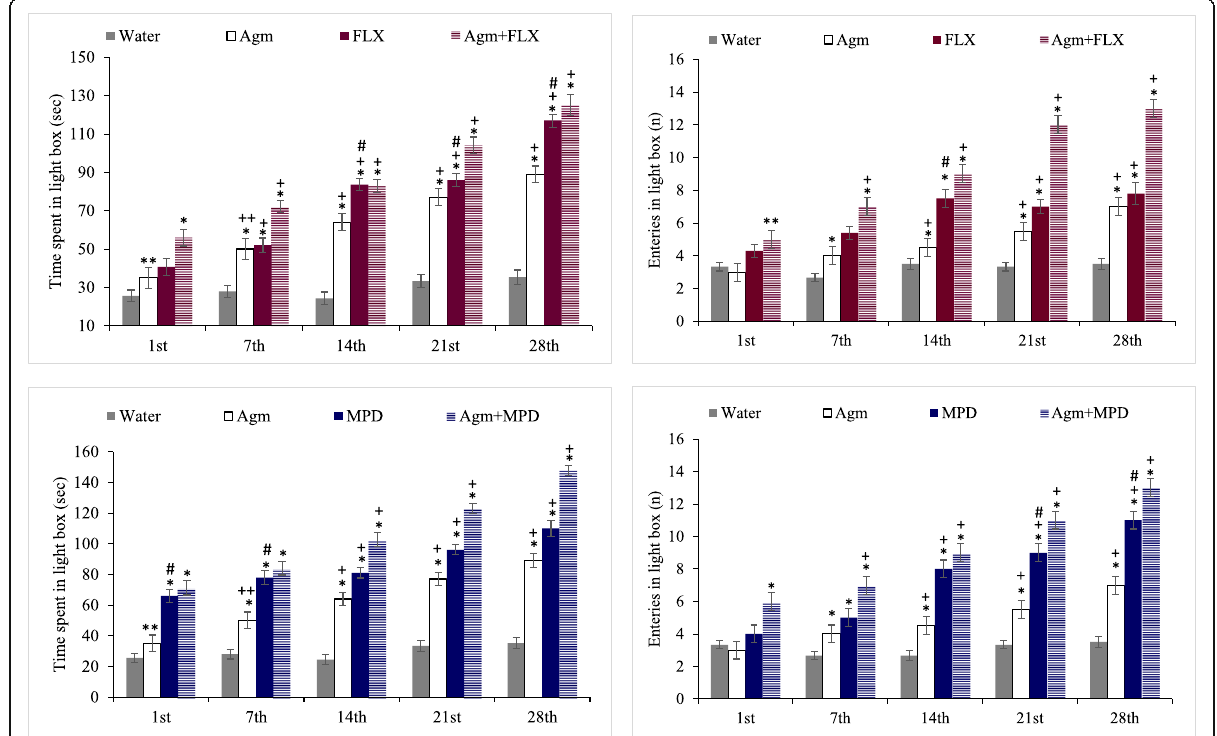
Fig. 5 a Light/dark transition test (time spent): values are expressed as means ± SD ( n =6). Significant differences by Newman-Keuls test: * p <0.01, ** p <0.05 from water-treated control group to drug-treated groups. + p <0.01, ++ p <0.05 from drug ’ s 1st administration. # p <0.01, ## p <0.05 from AGM-treated animals to FLX- and MPD-treated animals following two-way ANOVA. b Light/dark transition test (entries): values are expressed as means ± SD ( n =6). Significant differences by Newman-Keuls test: * p <0.01, ** p <0.05 from water-treated control group to drug-treated groups. + p